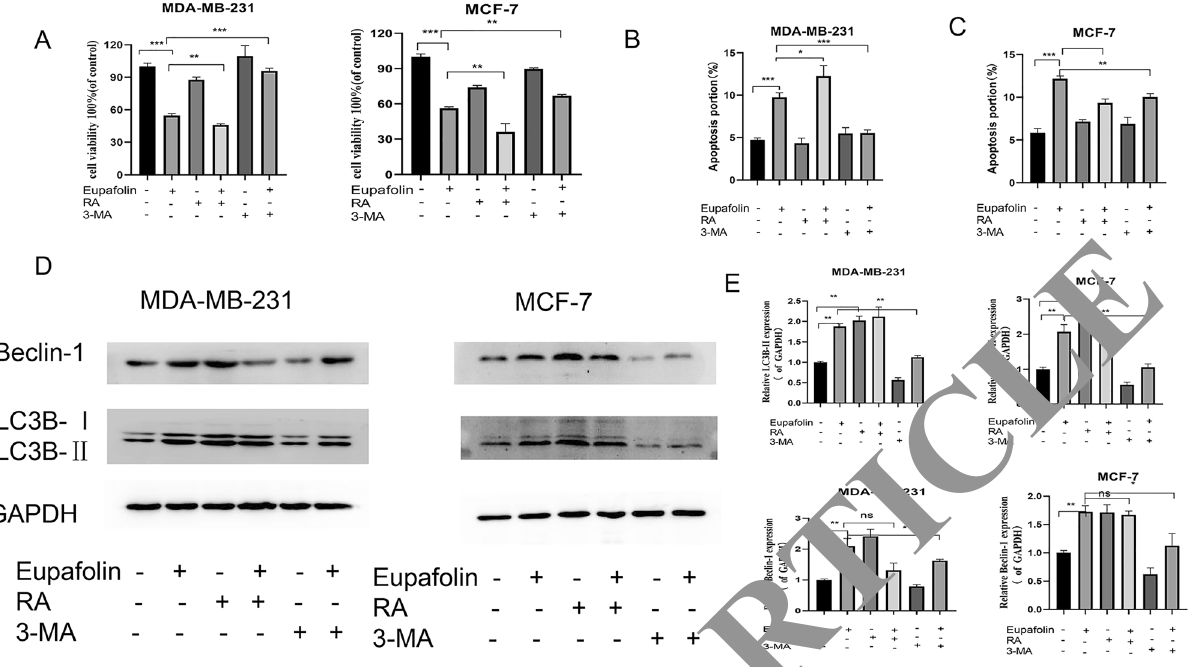
Figure 3. Eupafolin-induced apoptosis is accelerated by RA and inhibited by 3-MA in breast cancer cells. MDA-MB- 231and MCF-7 cells were pre-treated with or without 3-MA (5 mM) or RA (5 μM) for 2 h, followed by treatment with Eupafolin for another 24 h. All cells were then harvested for further analyses. ( A ) CCK-8 analysis for cell viability calculation. ( B , C ) Flow cytometry analysis for apoptosis. ( D , E ) Western blot analysis for Beclin-1 and LC3-II/LC3-I expression. Full-length images are presented in Supplementary Fig. 4. Graphs of signal intensity were obtained through band densitometry and referred to GAPDH and control levels. Data are representative of three independent experiments and expressed as mean ± SD. P > 0.05 indicates non-significance; ***P < 0.001; **P < 0.01; *P < 0.05.